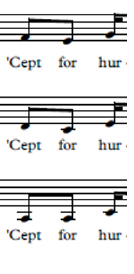
Figure 4. The first three chords of the fifth measure of the Hadestown excerpt; all voices treble